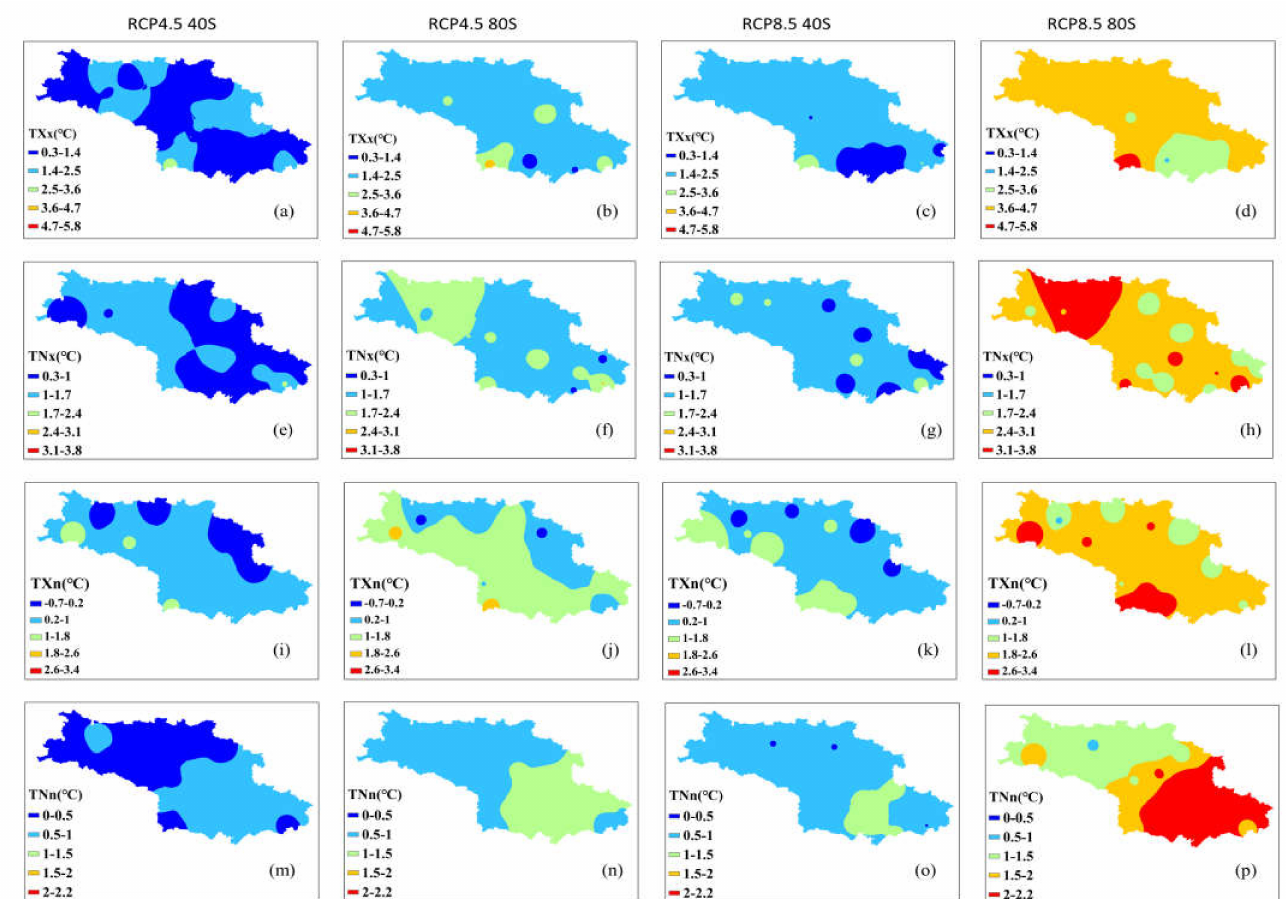
Figure 3. The spatial distribution of changes in the multi-model ensemble for the four intensity-based extreme indices (TXx, a – d ; TNx, e – h ; TXn, i – l ; TNn m – p ) during the 2040s and 2080s under two scenarios relative to 1971–2010 across the Han River